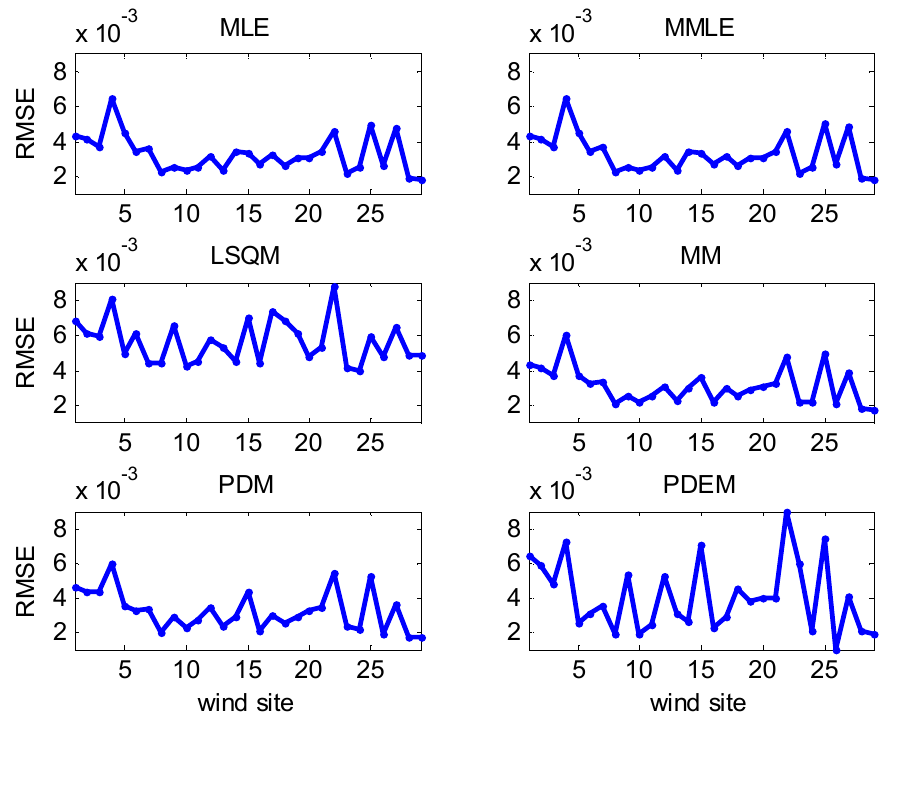
Figure 14. Representation of root mean square error ( RMSE ) at the different wind